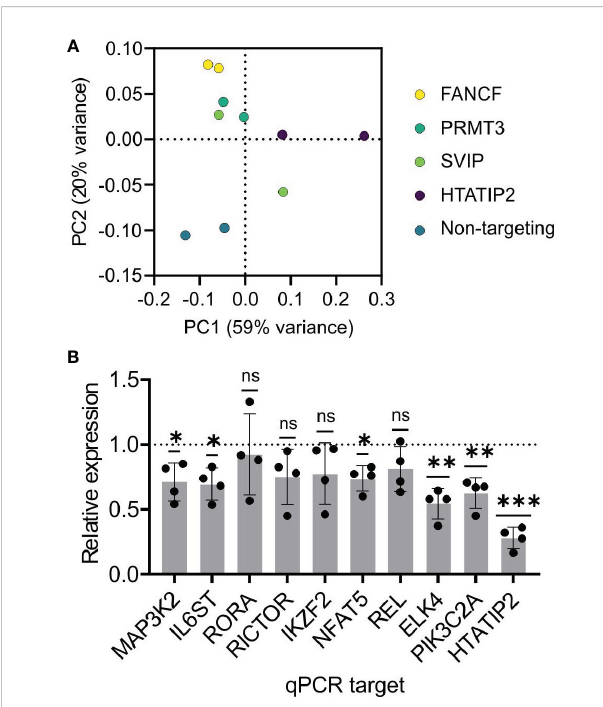
FIGURE 4 Gene expression analysis of candidate gene knock-down implicates HTATIP2 as a T cell regulator. Primary CD4 + T cells were electroporated with siRNA pools for the genes FANCF, PRMT3, SVIP, HTATIP2, or a non-targeting control siRNA in biological duplicates. Poly-A-tailed mRNA was subjected to transcriptome sequencing. (A) Principal components analysis of the ten samples color-coded by the siRNA. (B) Knock-down of HTATIP2 using siRNA in primary CD4 + T cells from four donors. mRNA levels of the indicated genes were assayed by RT-qPCR and normalized to the mRNA level of the non- targeting siRNA-transfected cells for each donor. ns, non-signi fi cant; *P < 0.05, **P < 0.01, ***P < 0.001.